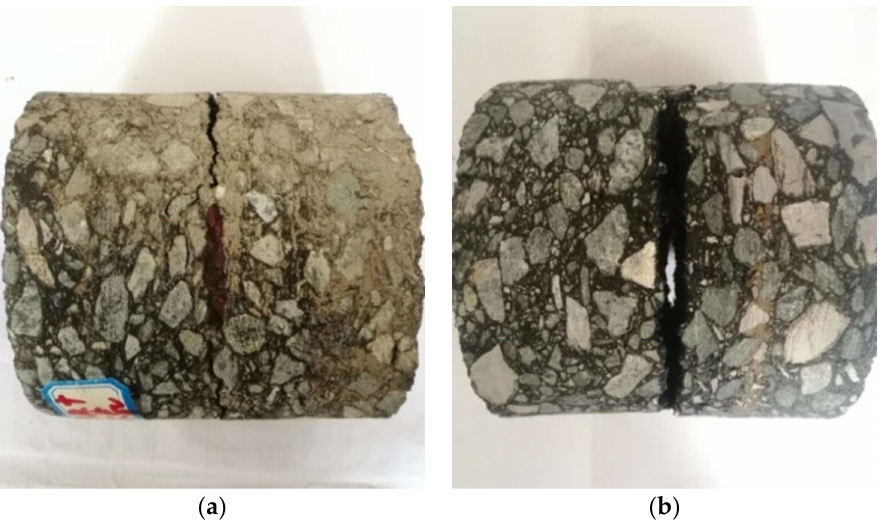
Figure 7. Interlayer bond failure of the indirect tensile test specimen: ( a ) SBR modified emulsified asphalt sample; ( b ) SW binder sample.